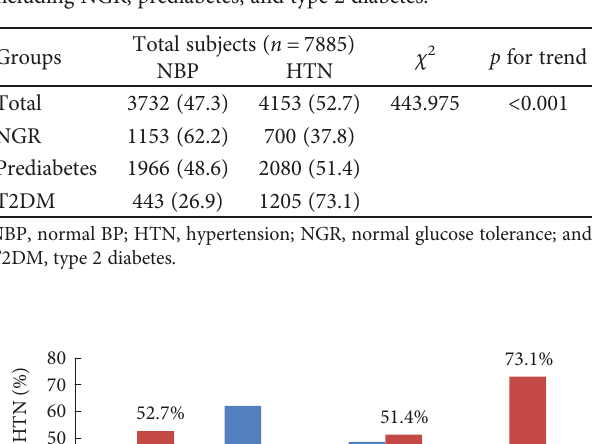
Table 1: The prevalence of hypertension in the total participants including NGR, prediabetes, and type 2 diabetes.